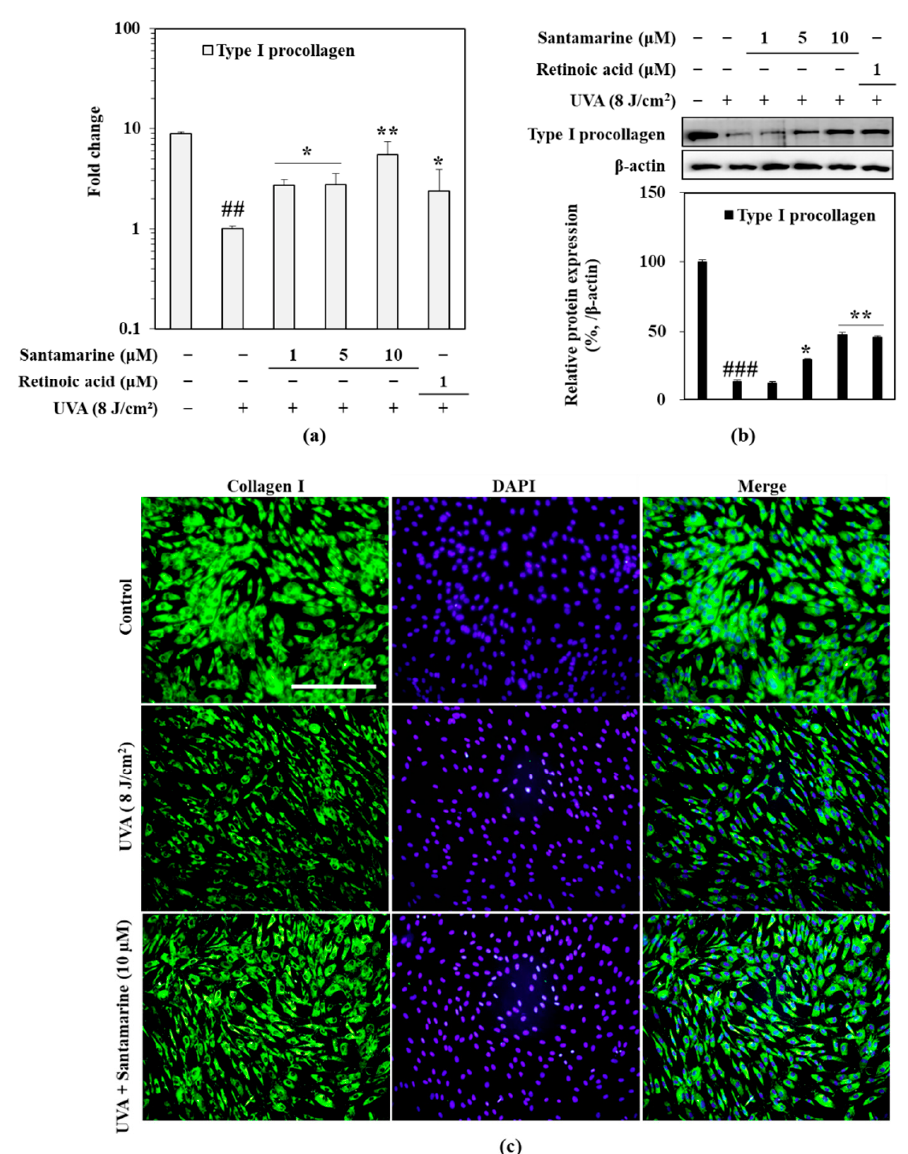
Figure 6. Effect of santamarine on the collagen production in UVA-irradiated (8 J/cm 2 ) HDFs. Effect of santamarine on the mRNA expression ( a ) and protein level ( b ) of type I procollagen was analyzed after 24 h treatment post-UVA-irradiation via RT-qPCR and Western blot, respectively. β -actin was used as a loading control. Values are means ± SD ( n = 3). ( c ) Fluorescence-stained images of the HDFs were taken after staining with FITC conjugated anti-collagen I antibody (green) and DAPI (blue) to highlight the nuclei. Scale bar, 100 µ m. * p < 0.05 and ** p < 0.01 vs. UVA-irradiated untreated control. ## p < 0.01 and ### p < 0.001 vs. non-irradiated control. Retinoic acid was used as positive control.